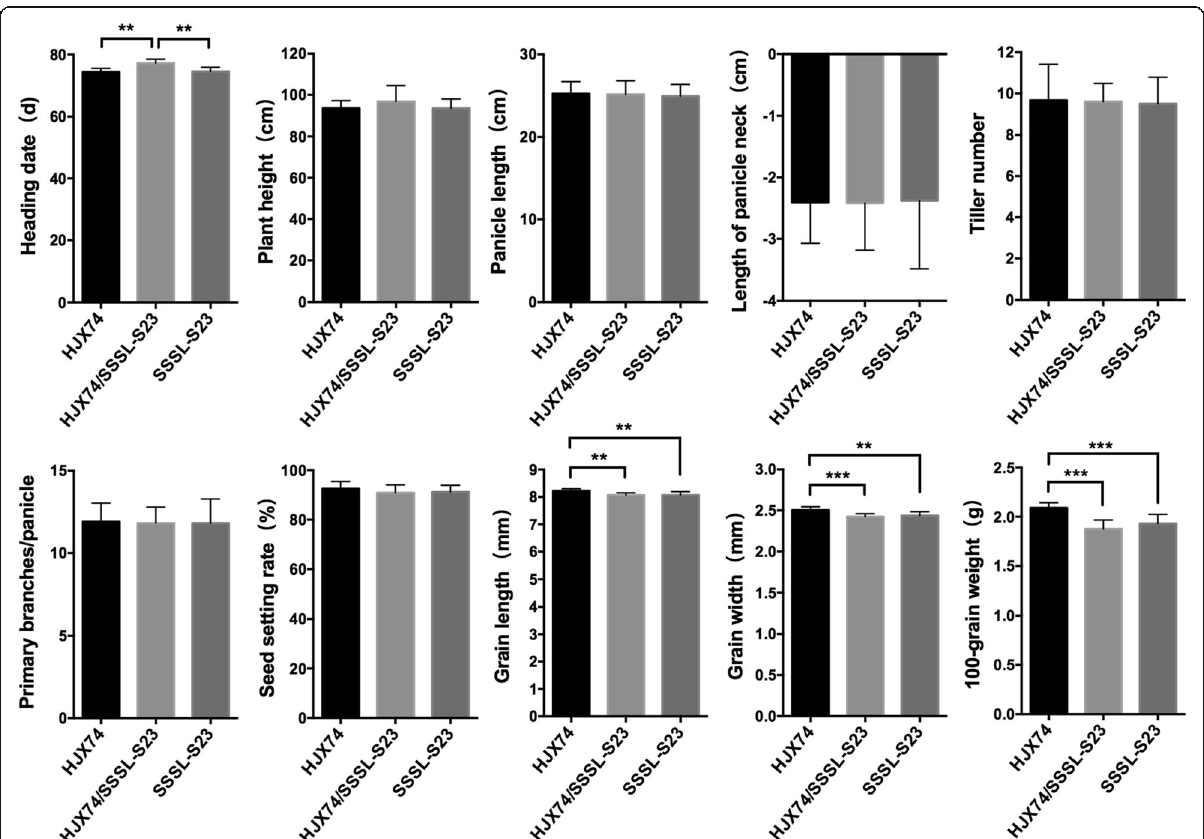
Fig. 3 Ten key agronomic traits in HJX74, SSSL-S23 and HJX74/SSSL-S23 F 1 plants in NSD. ** and *** represented significance at P = 0.01 and P = 0.001,